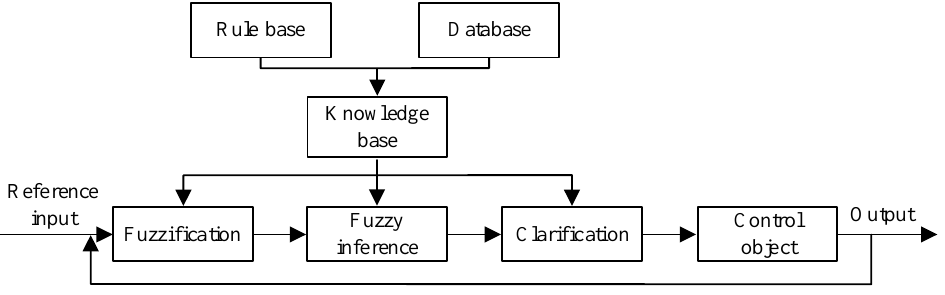
Figure 3. Structure of the fuzzy controller.